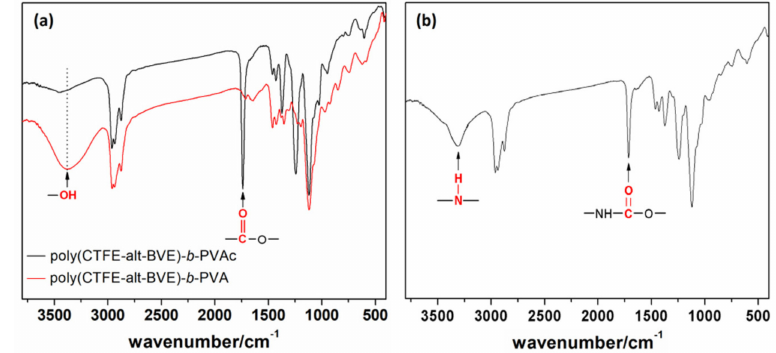
Figure 5. FT-IR spectra of ( a ) poly(CTFE-alt-BVE)- b -PVAc, poly(CTFE-alt-BVE)- b -PVA, and ( b ) the fluorinated